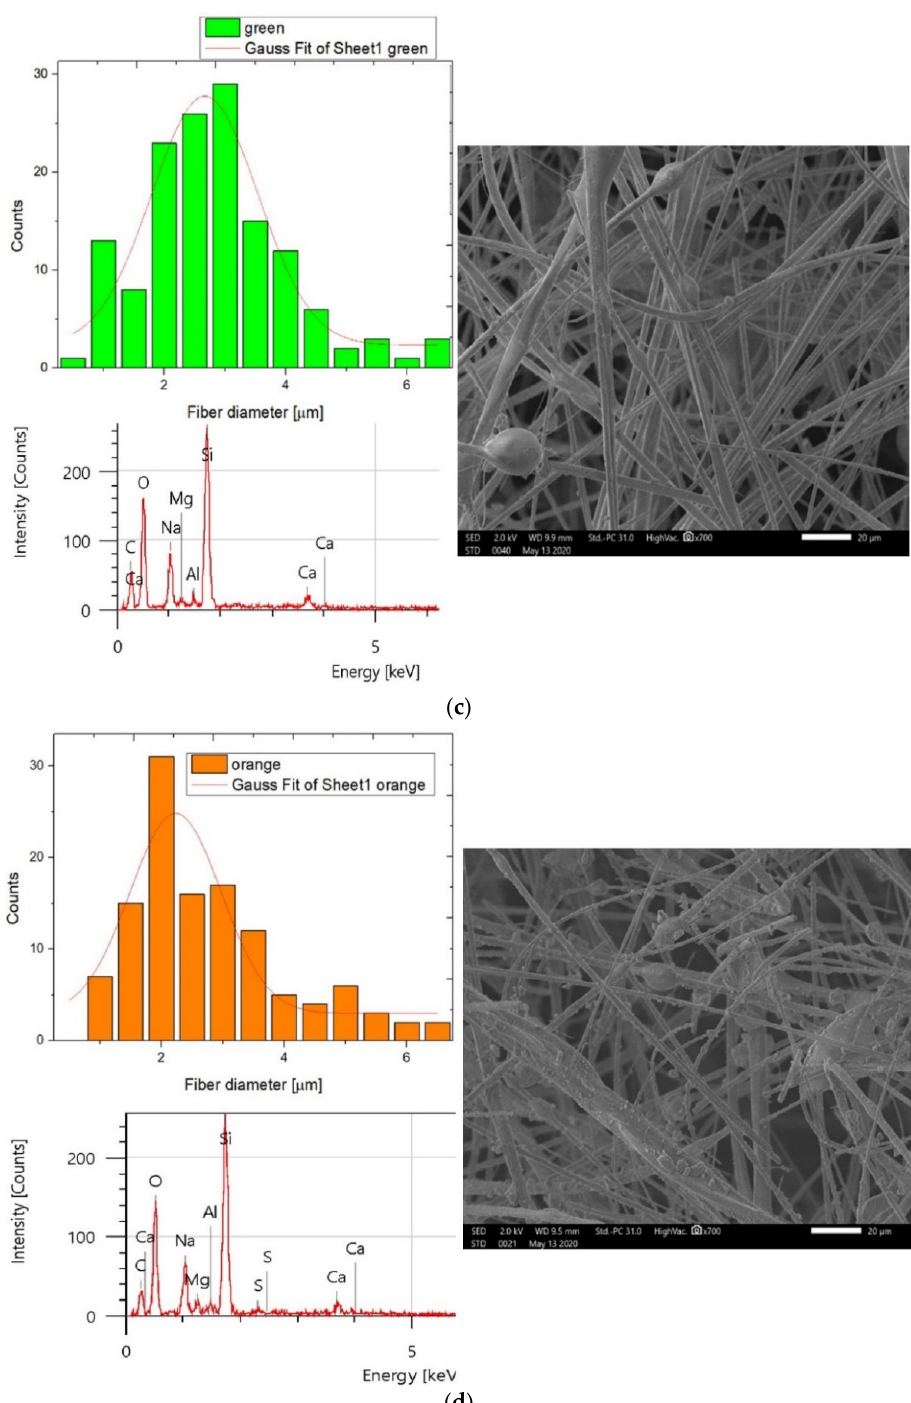
Figure 2. ( a ) SEM and EDS results of the pink sample with a Gaussian distribution of the diameter of the measured fiber. ( b ) SEM and EDS results of the yellow sample with a Gaussian distribution of the diameter of the measured fiber. ( c ) SEM and EDS results of the green sample with a Gaussian distribution of the diameter of the measured fiber. ( d ) SEM and EDS results of the orange sample with a Gaussian distribution of the diameter of the measured fiber.